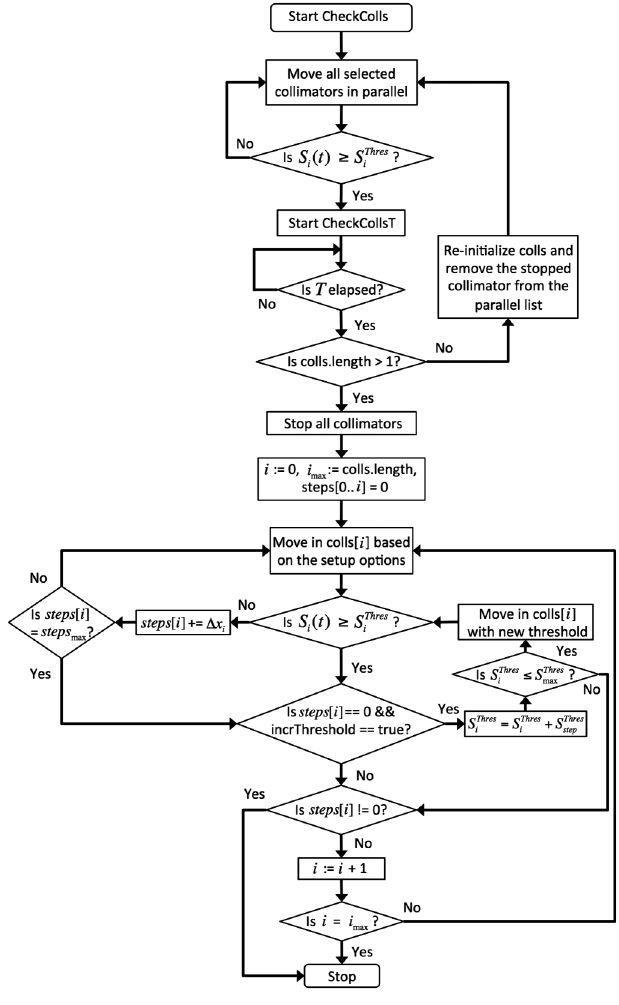
FIG. 8. A flowchart of the software process that automatically identifies which collimator jaw is at the beam after multiple collimators stop moving due to cross talk.